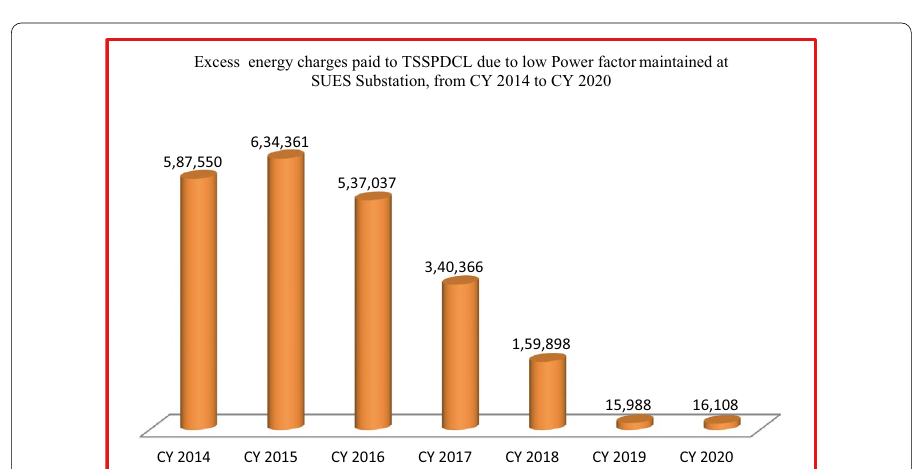
Fig. 25 Excess energy charges paid to TSSPDCL due to low PF